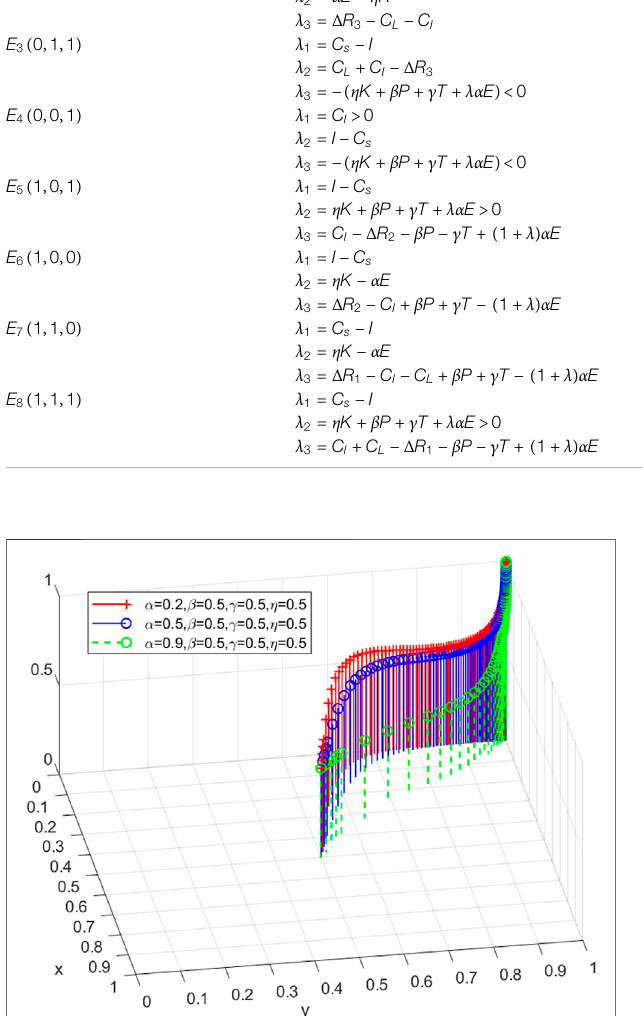
executive strengths of pollution tax, subsidies, propaganda,